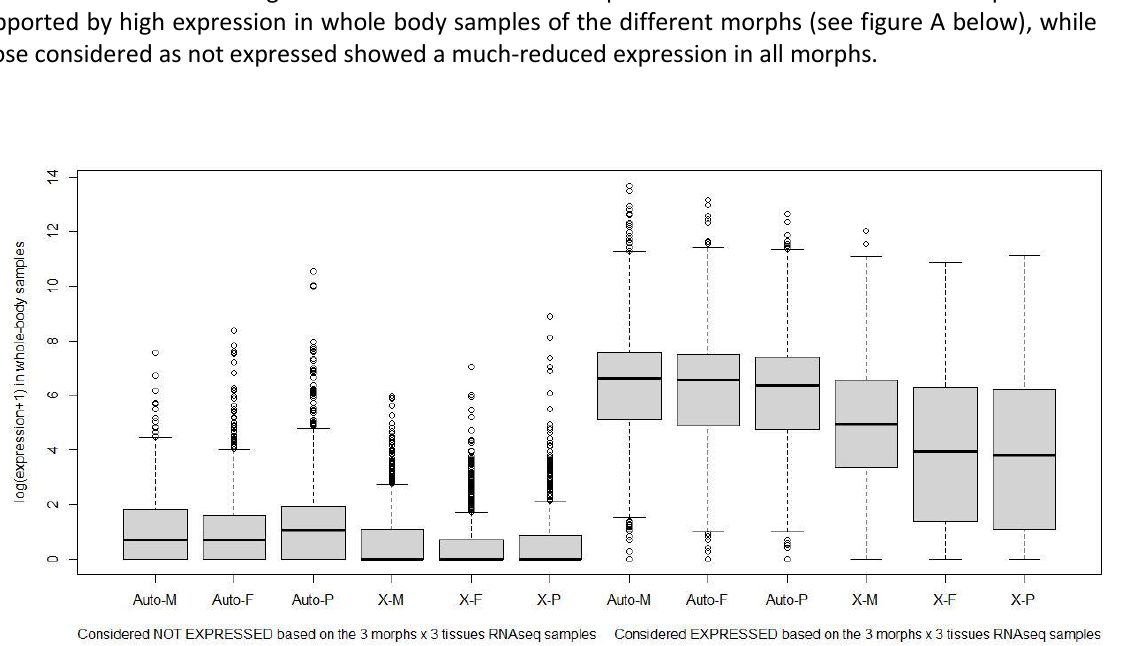
Figure A : Gene expression in whole body samples of males (M), sexual females (F) and parthenogenetic females (P) as a function of the gene localization (X vs Autosomes) and of whether the gene is considered as expressed or not in the 3-morph x 3-tissue RNAseq